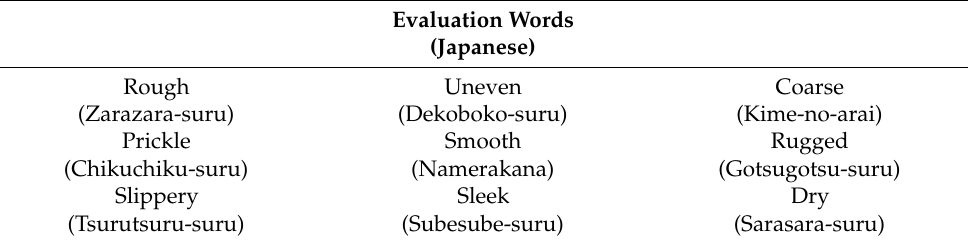
Table 1. Words used in the sensory evaluation test (terms in brackets are in